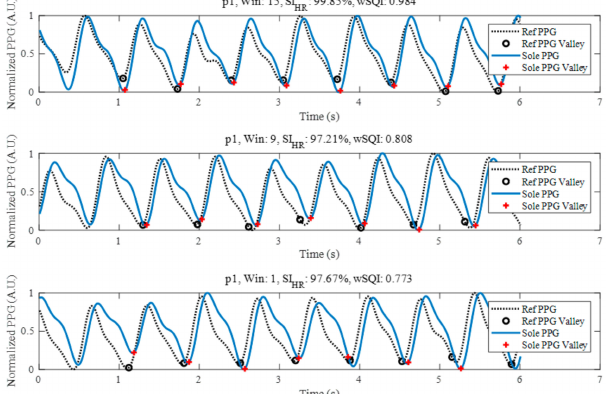
Figure 4. SI HR and wSQI as a function of the time window of foot PPG of participant 1 (p1) with probe location 2, PD F17 and direct skin contact.